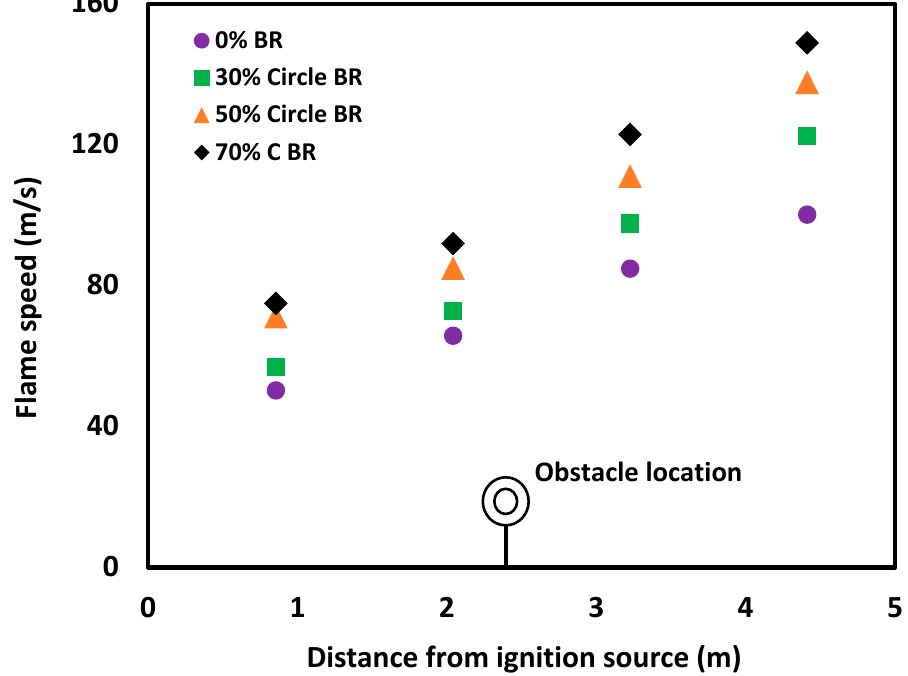
Figure 9. Flame propagation speed for experiments with 10% methane concentration in the straight tube and when the tube included a 30%, 50% or 70% orifice plate placed 2.4 m from the ignition source.